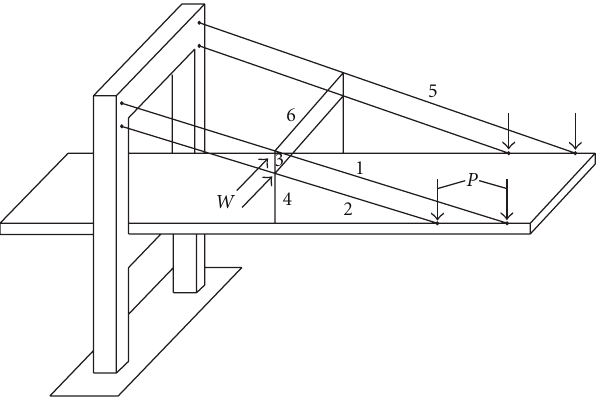
Figure 1: Part of a typical cable-stayed bridge [1].